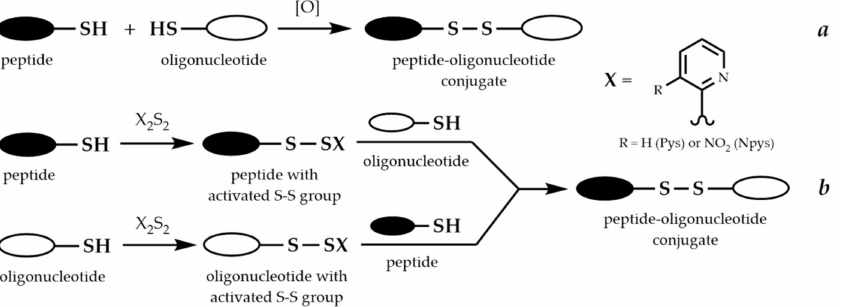
Figure 11. Conjugation through the disulfide bond: ( a ) by direct oxidation and ( b ) via activation by a pyridylsulfenyl (Pys) or a 3-nitropyridylsulfenyl (Npys)